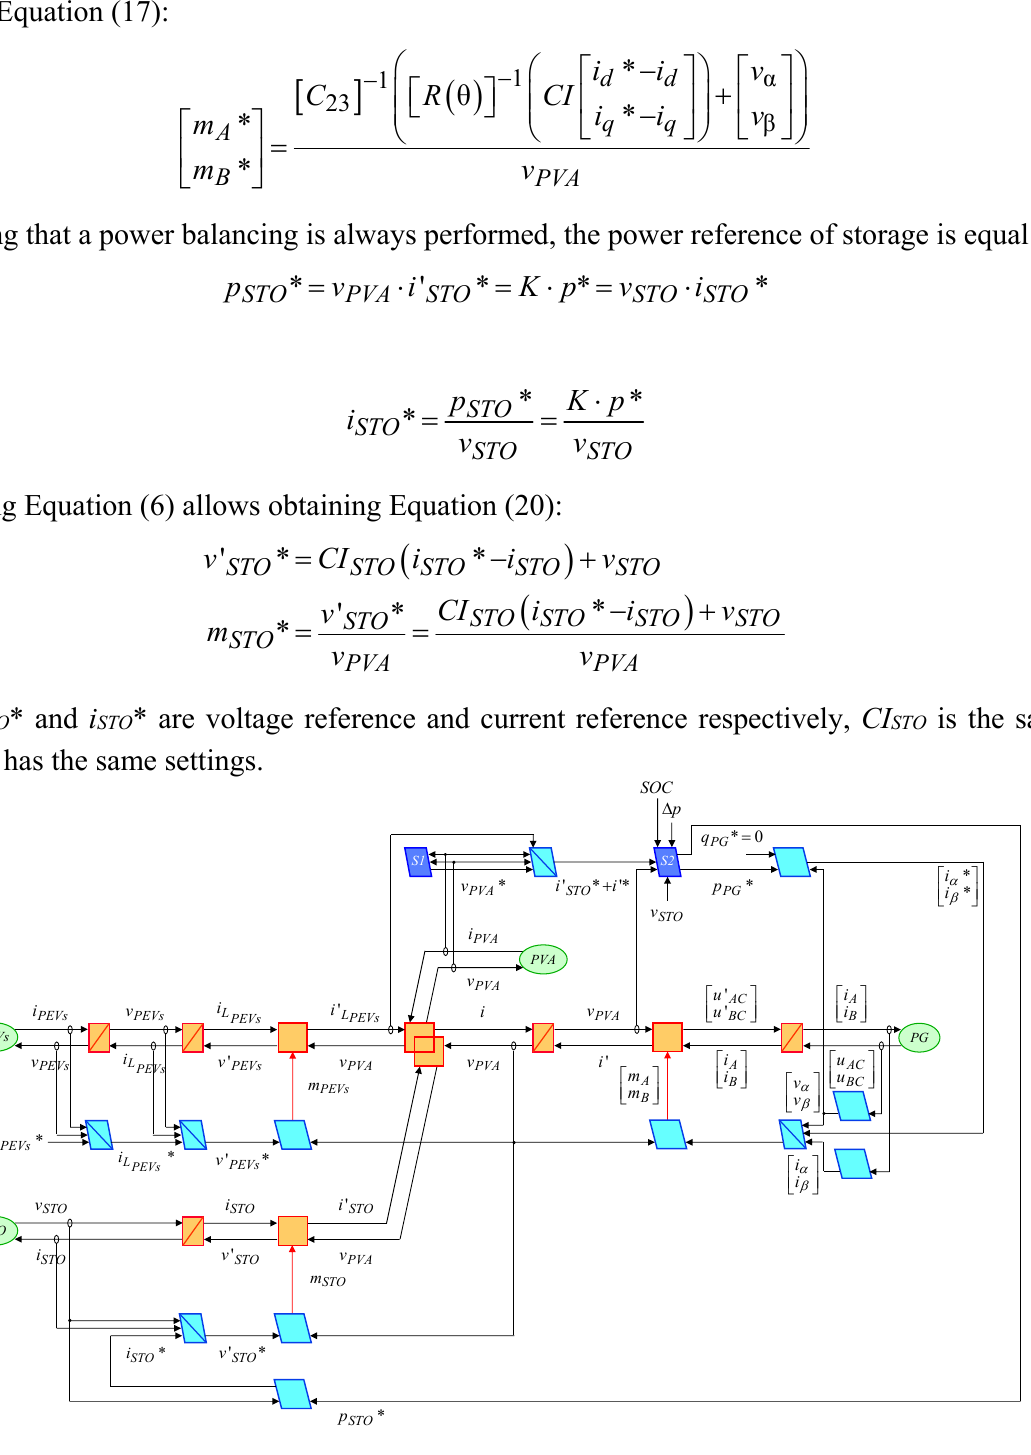
Figure 9. Maximum Control Structure for the DC microgrid for PEVs charging